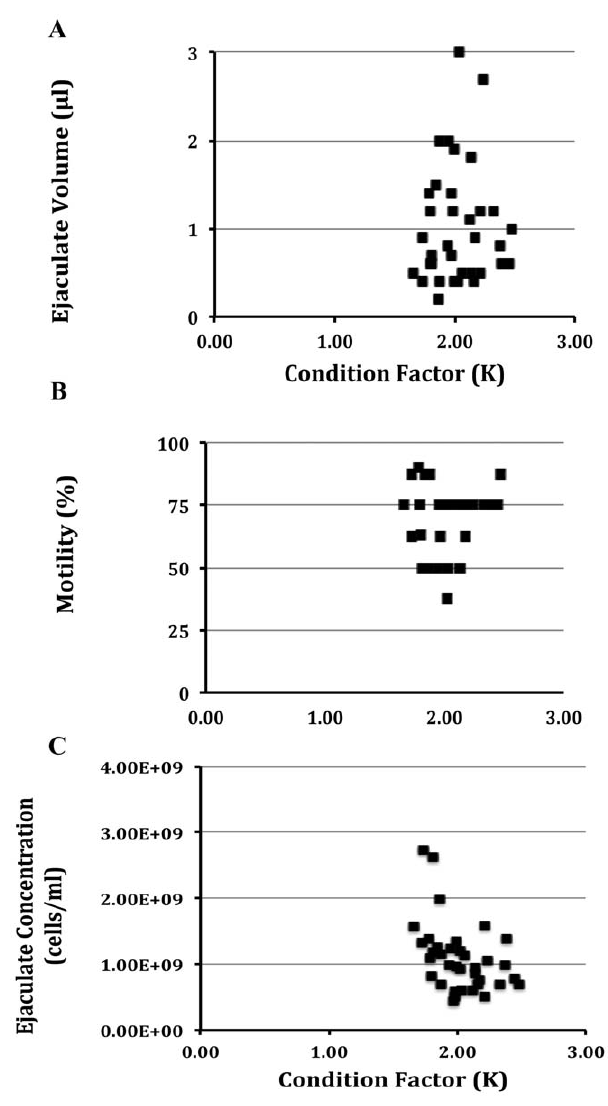
Figure 1. Reproductive traits and body condition. Male zebrafish (N=35) were squeezed and their body condition (K = 100,000 x weight/ (standard length) 3 ) determined and correlated with characteristics of the undiluted ejaculated. A) Body condition (K) did not correlate with sperm volume or B) motility, but C ) increasing body condition (K) correlated with a decreasing sperm concentration. Analysis suggested that there was no correlation between body condition and sperm motility, nor body condition and ejaculate volume (Fig. 1 A and B; P . 0.05, Linear regression). However, paradoxically, fish with increasing body condition, produced less concentrated sperm (Fig. 1C; P , 0.05).